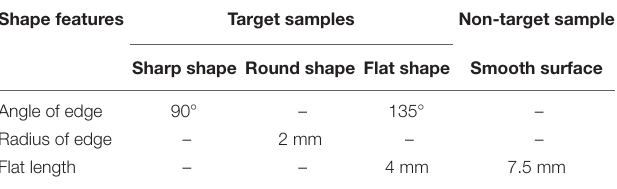
TABLE 2 | Shape features of ridge